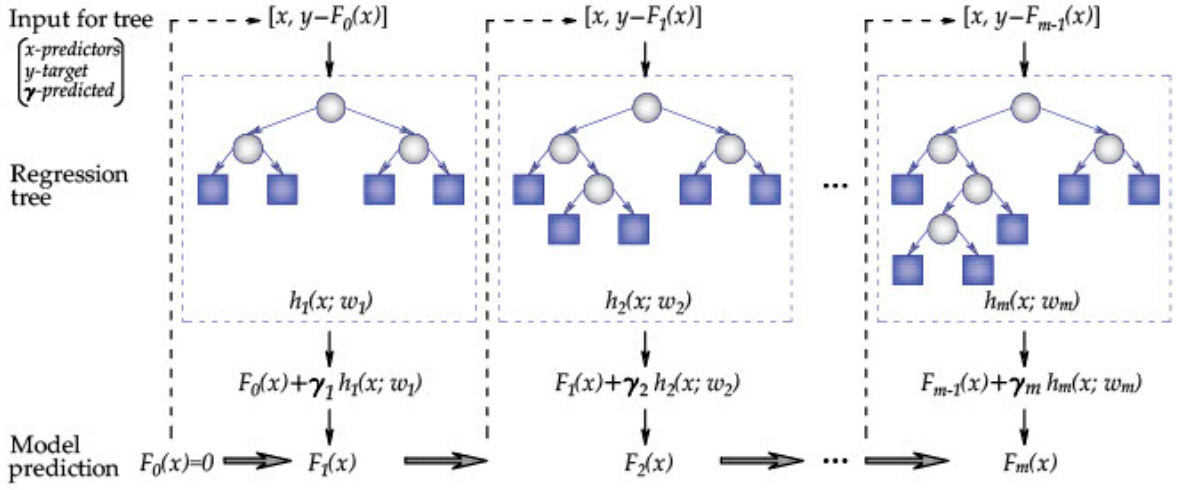
Figure 5. Schematic diagram of the gradient boosted regression tree.